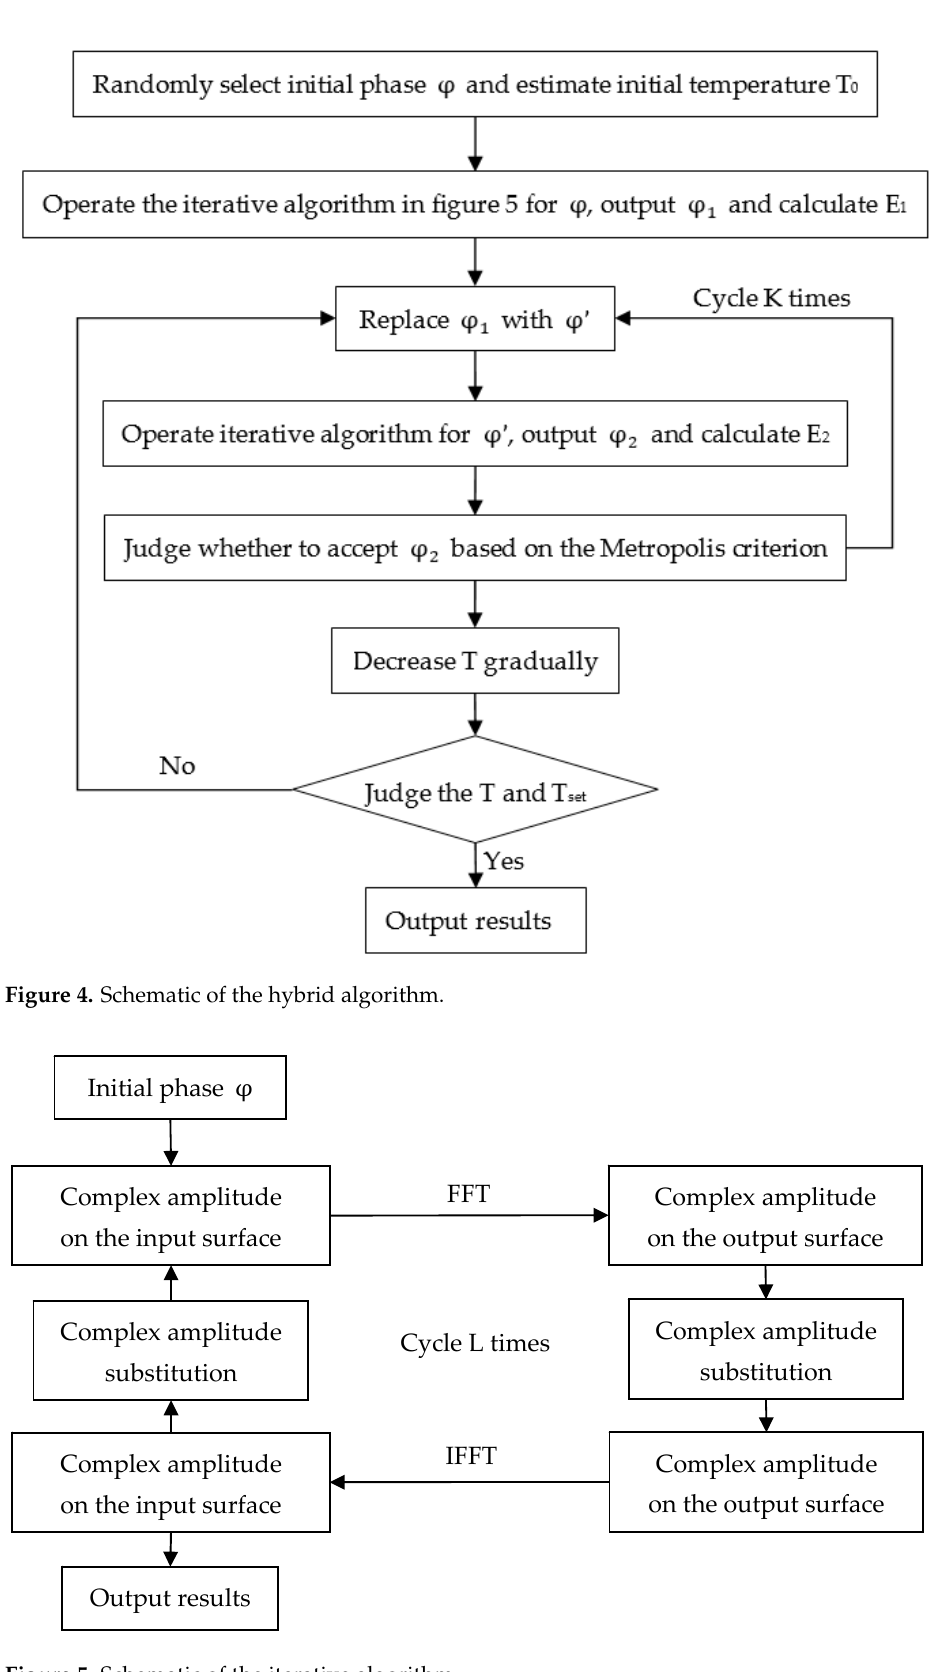
Figure 5. Schematic of the iterative algorithm.